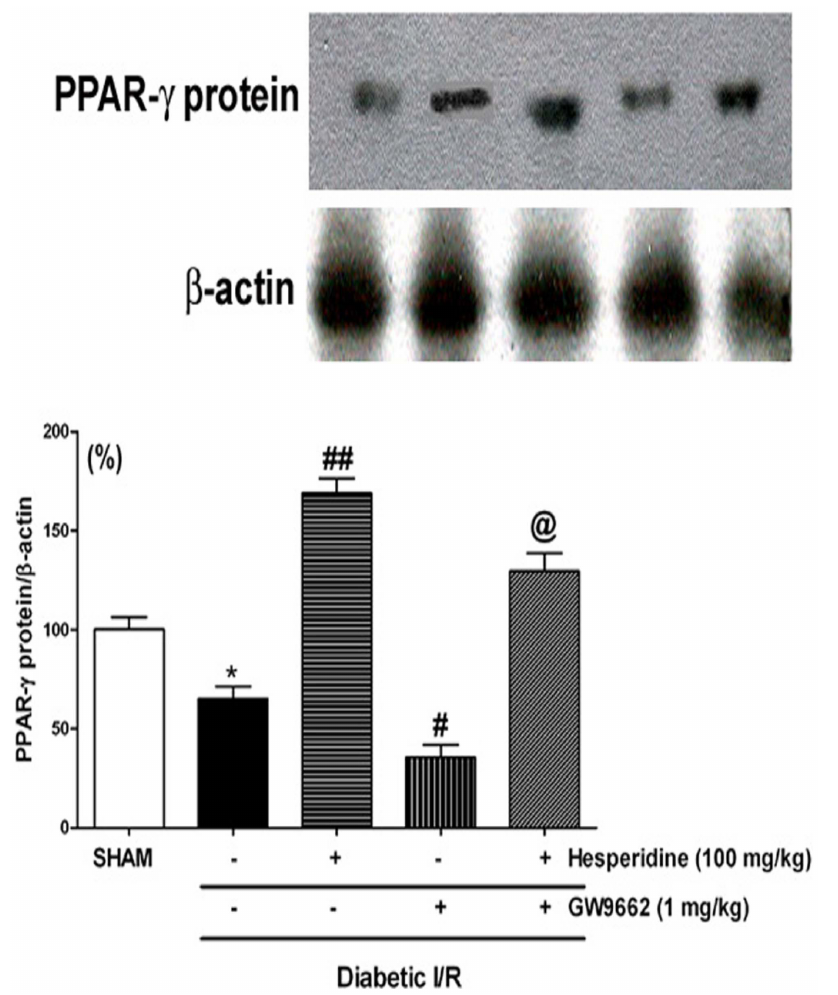
Figure 6. Effect of hesperidin and GW9662 (PPAR- c antagonist) on PPAR- c expression (top) in ischaemia/reperfusion (I/R)-induced myocardial infarction in diabetic rats. The bar graphs show PPAR- c protein expression that has been normalized to b -actin (bottom). Data are expressed as a ration of the value determined for the vehicle (diabetic sham) (set as 100%). Data are expressed as the mean 6 standard error. *p , 0.05 vs Diabetic SHAM; # p , 0.01, # p , 0.001 vs Diabetic I/R; @p , 0.05 vs Hesperidin.